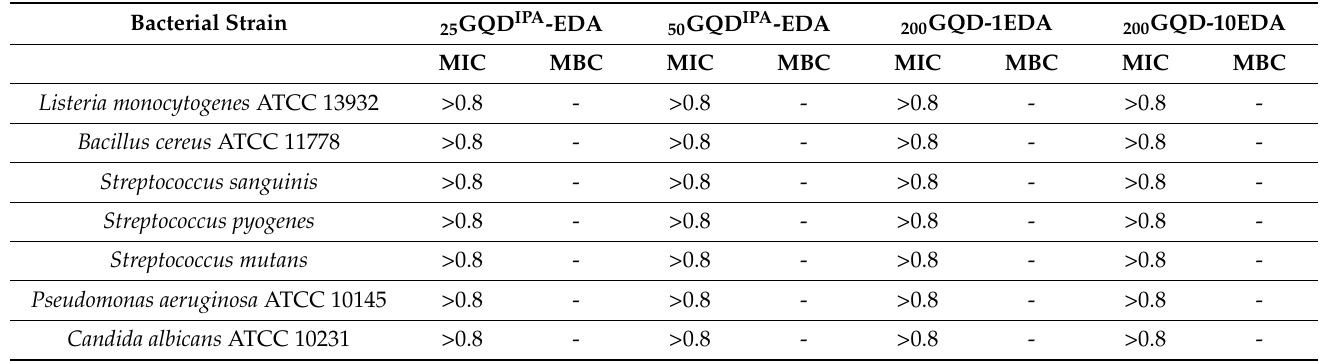
Table 2. Minimum inhibitory concentrations of GQD-EDA/1 g and GQDs-EDA/10 g (in mg · mL − 1 ). Bacterial Strain 25 GQD IPA -EDA Listeria monocytogenes ATCC 13932